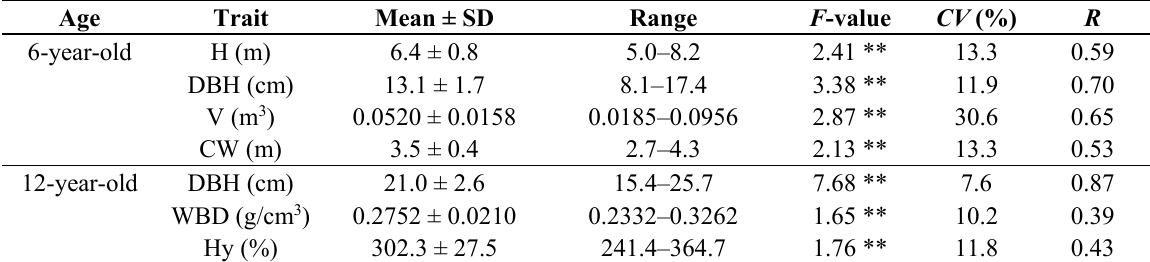
Table 1. Mean, range, variance and repeatability of the morphological traits of Chinese fir parent clones. H, height; DBH, diameter at breast height; V, stem volume; CW, crown-width; WBD, wood basic density; Hy, wood hygroscopicity; F -value, ANOVA F (** p < 0.01); CV , coefficient of variation; R , repeatability. Age Trait Mean ± SD